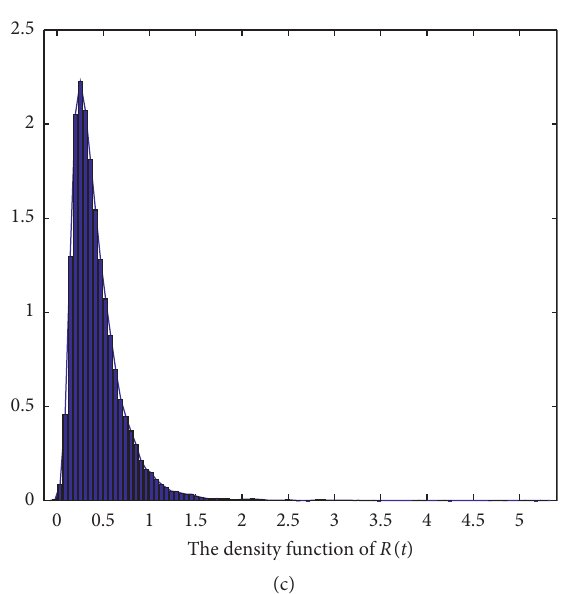
Figure 3: The histograms of the solution ( S ( t ) ,I ( t ) , R ( t )) of stochastic system (4) with the environmental white noise intensity � 0 . 2 , σ � 0 . 2 , and σ � 0 . 3. (a) The density function of S ( t ). (b) The density function of I ( t ). (c) The density function of R ( t σ 1 2 3